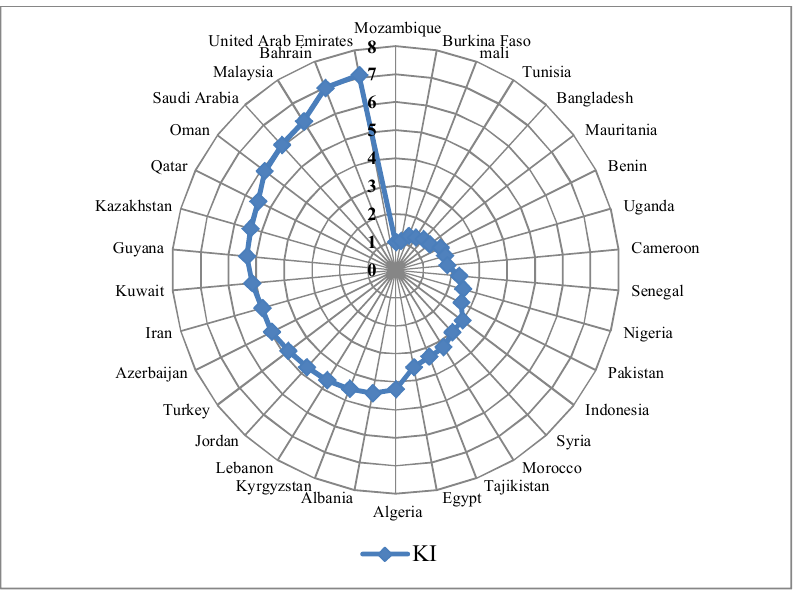
Fig. 3. Position of KI in OIC countries